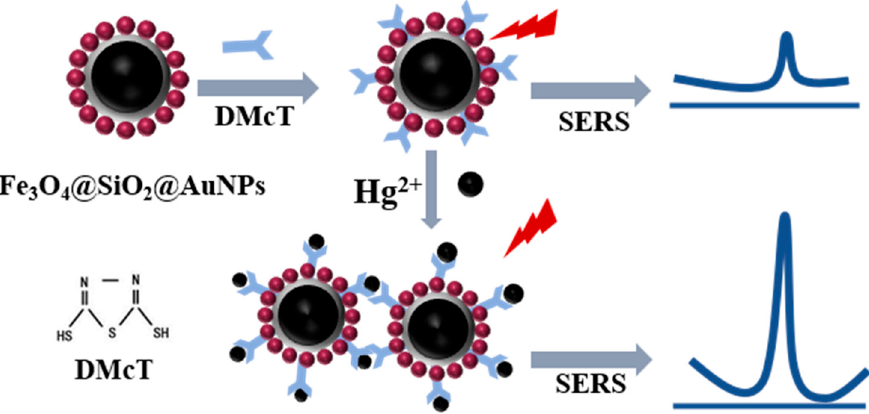
Figure 3. Schematic diagram of Hg 2+ detection based on DMcT-functionalized Fe 3 O 4 @SiO 2 @AuNPs.